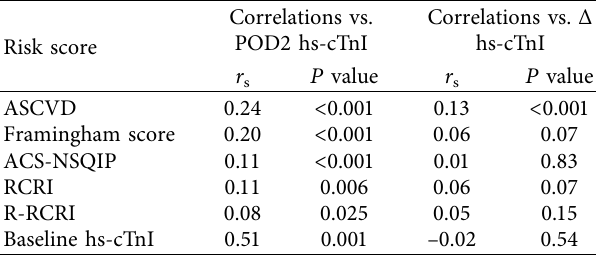
s ) of score vs. POD2 hs-cTnI. Correlations